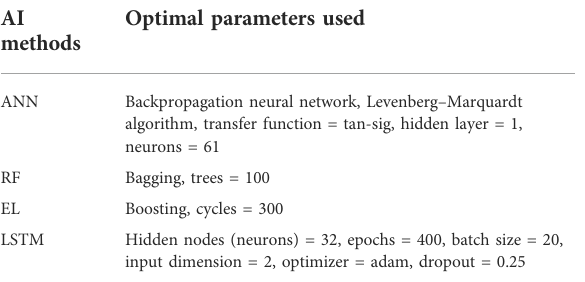
methods for distinguishing between the converter faults and the transmission line faults.